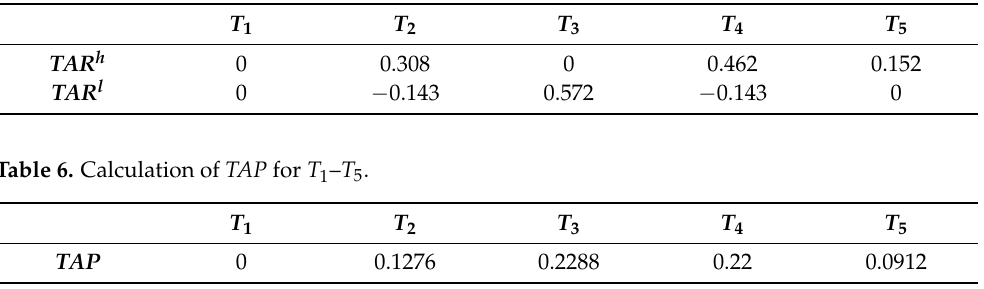
Table 3. Number of grid codes for 𝑇 1 − 𝑇 5 .